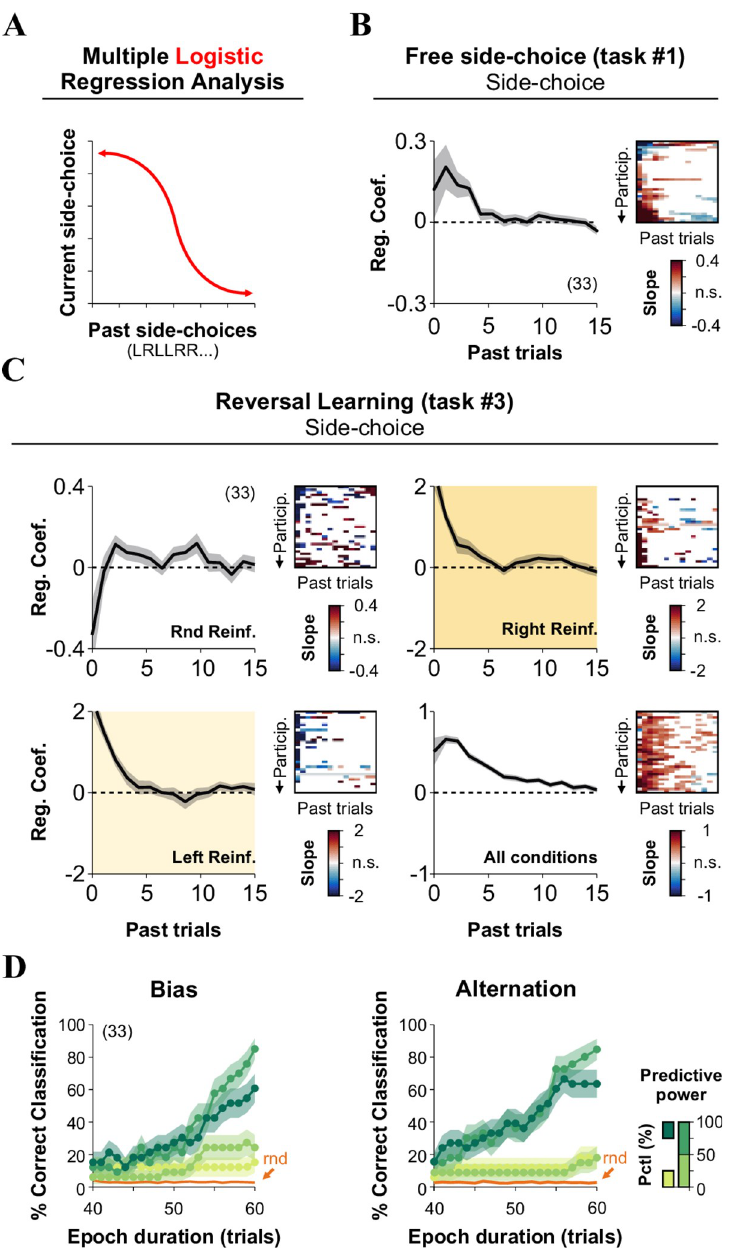
Fig 4. Past decisions influence side-choices in multiple tasks. (A) We conducted a multiple logistic regression analysis to predict current side-choice behavior from past side-choices, using the same data as in the previous experiment where participants solved the free side-choice (task #1, B) and the reversal learning (task #3, C) tasks. For task #1, the probability of repeating a side was strongly influenced by the amount of previous side-biased choices (B). For task #3, the odds of repeating the same side increased when side-choices were reinforced but decreased when alternating choices were reinforced (C). (D) Cumulative match characteristic curves as a function of epoch duration (x-axis). The curves were calculated by using different sets of predictors with their strength identified by using a stepwise regression learner. Classifications were performed using predictors falling in different percentile ranges, as indicated by the color bar on the right. Number of subjects in